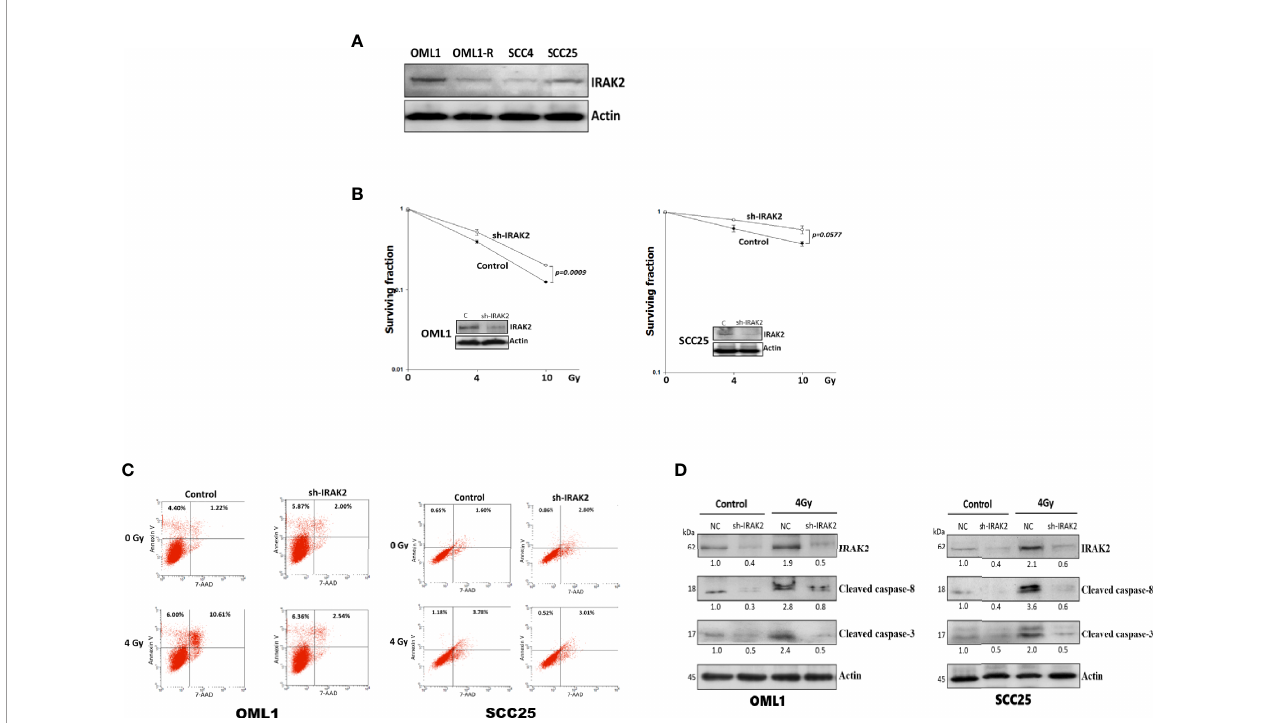
FIGURE 3 | The knockdown of IRAK2 promoted resistance to IR-induced apoptosis in OML1 and SCC25 cells. (A) Endogenous IRAK2 expression in different OSCC cell lines, showing higher expressions of IRAK2 in OML1 and SCC25 than that of OML1-R and SCC4 cells. The values under bands represented the relative density that normalized to b -actin. (B) When compared with their control cells, post-irradiation colony formation rates were increased in IRAK2-knockdown OML1 (P = 0.0009) and SCC25 (P = 0.0577) cells. (C) Effect of radiation, IRAK2 shRNA or both on cell apoptosis in OML1 and SCC25 cell lines. Flow cytometry analysis using Annexin V and 7-AAD staining was performed to detect apoptotic cells. (D) IRAK2-shRNA transfection decreased the expressions of cleaved caspase-8 and caspase-3 in OML1 (left) and SCC25 (right) cancer cells. Densitometry-derived values (bottom) were normalized with the control set as 1. b -actin served as the loading control for